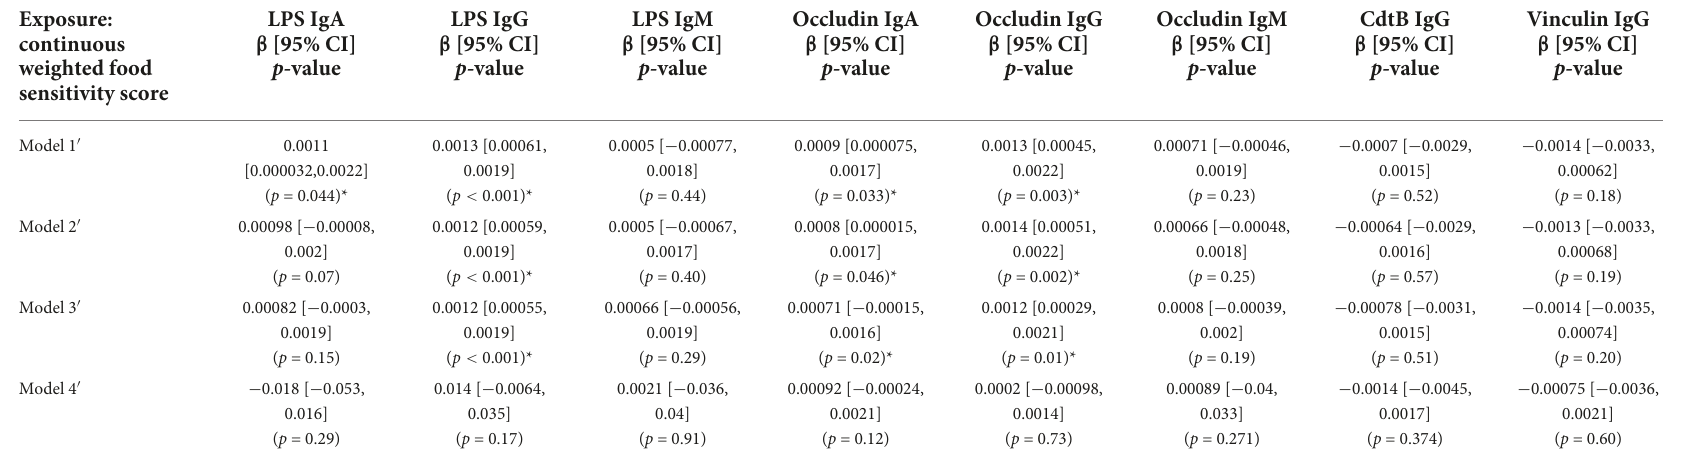
TABLE 6 Association between intestinal permeability biomarkers and continuous weighted food sensitivity score ( n =